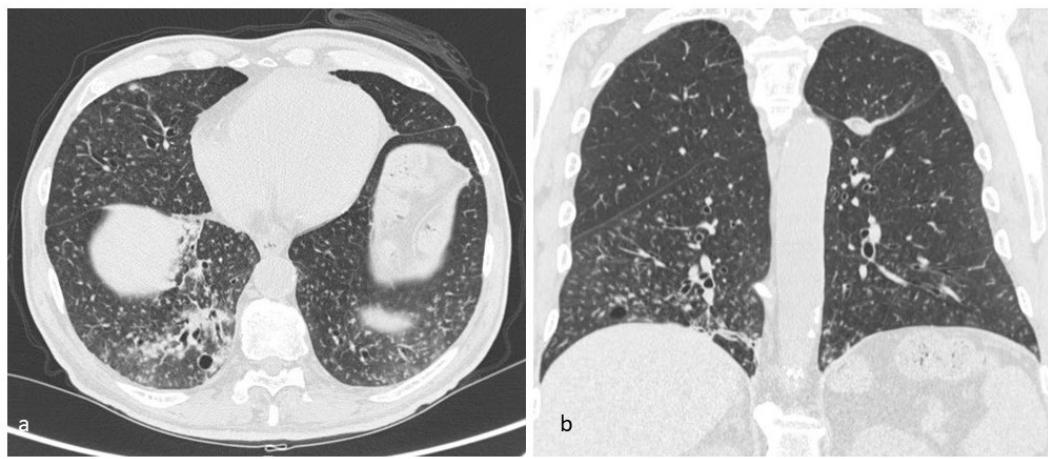
Figure 16. Pneumatocele in a patient with known infection from Pneumocystis carinii . Multiplanar reconstruction (MPR) in the coronal plane ( b ). A thin-walled cystic air space is located in the lateral-basal segment of the lower right lobe ( a ).